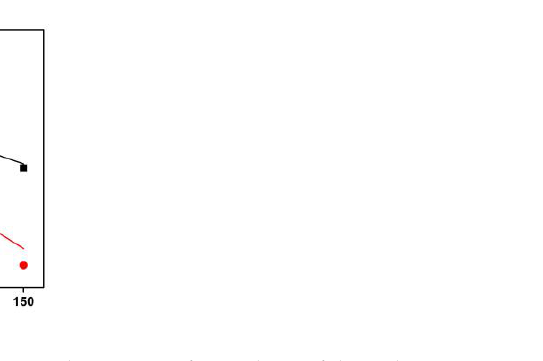
Figure 10. Absorbances of MB under photocatalytic degradation for different UV irradiation time using ( a ) ZnO photocatalyst, ( b ) Ti-ZnO photocatalyst, and ( c ) no photocatalyst.